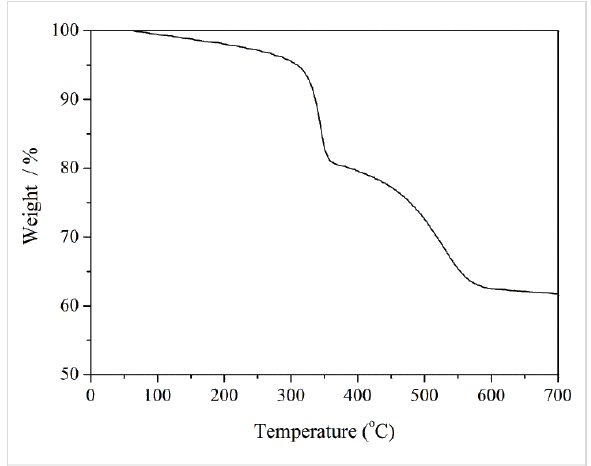
Figure 3: TG curve of Fe 2 O 3 /COOH-MWCNT composites.